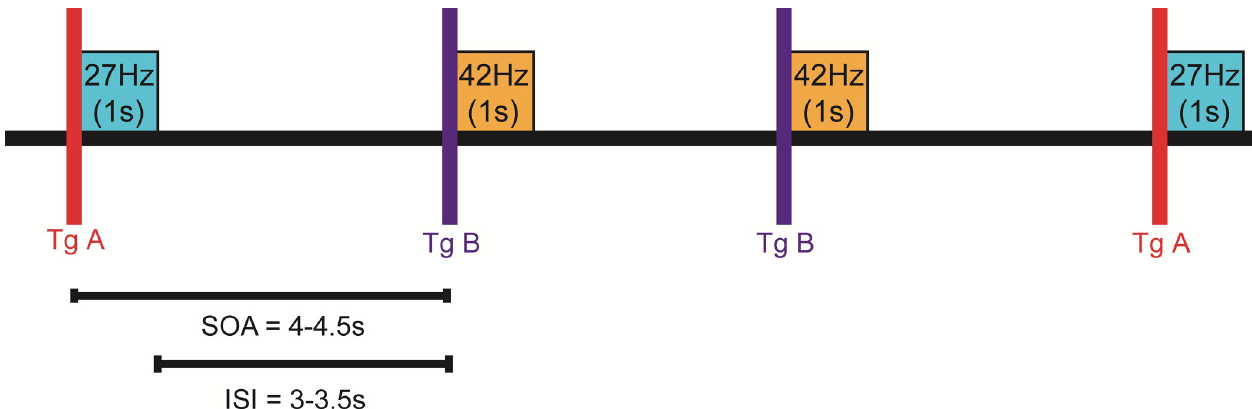
Fig 1. Stimulation paradigm. Illustration of the stimulation paradigm using AM tones with a MF of 27 Hz or 42 Hz in a random sequence. The specific frequency was encoded by a unique trigger value (Tg A or Tg B). The inter-stimulus interval (ISI) and the stimulus-onset asynchrony (SOA) are displayed.